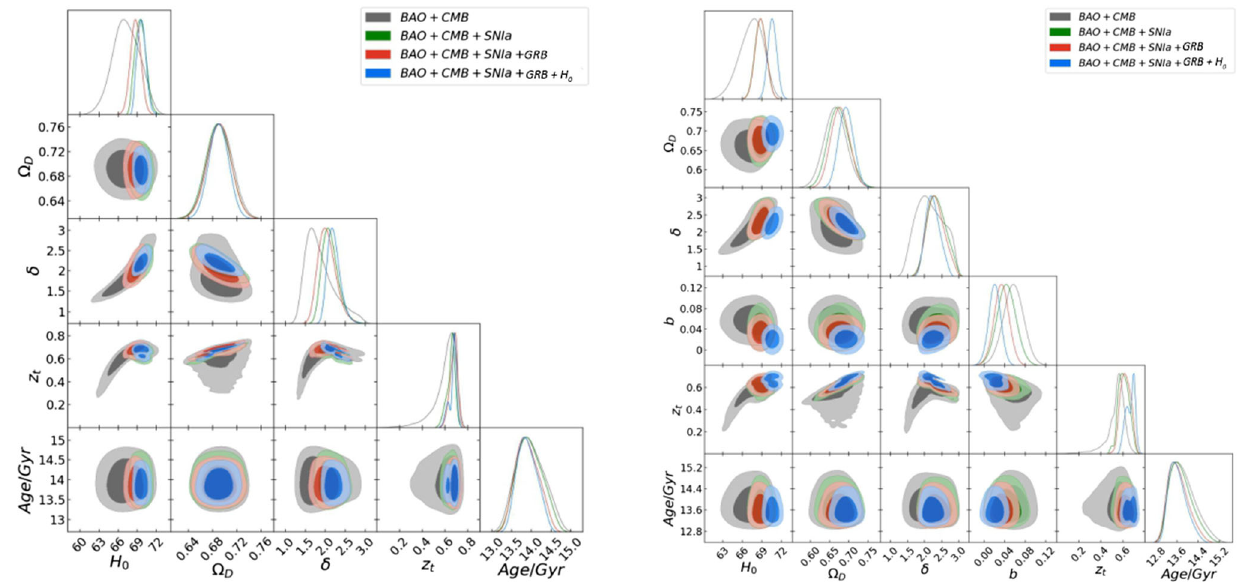
Fig. 1 The contour maps of the non-interacting THDE with consider- ation of the Hubble horizon as IR cutoff. In this figure H 0 is the Hubble parameter, (cid:4) D is the dark energy density, δ is the free parameter of